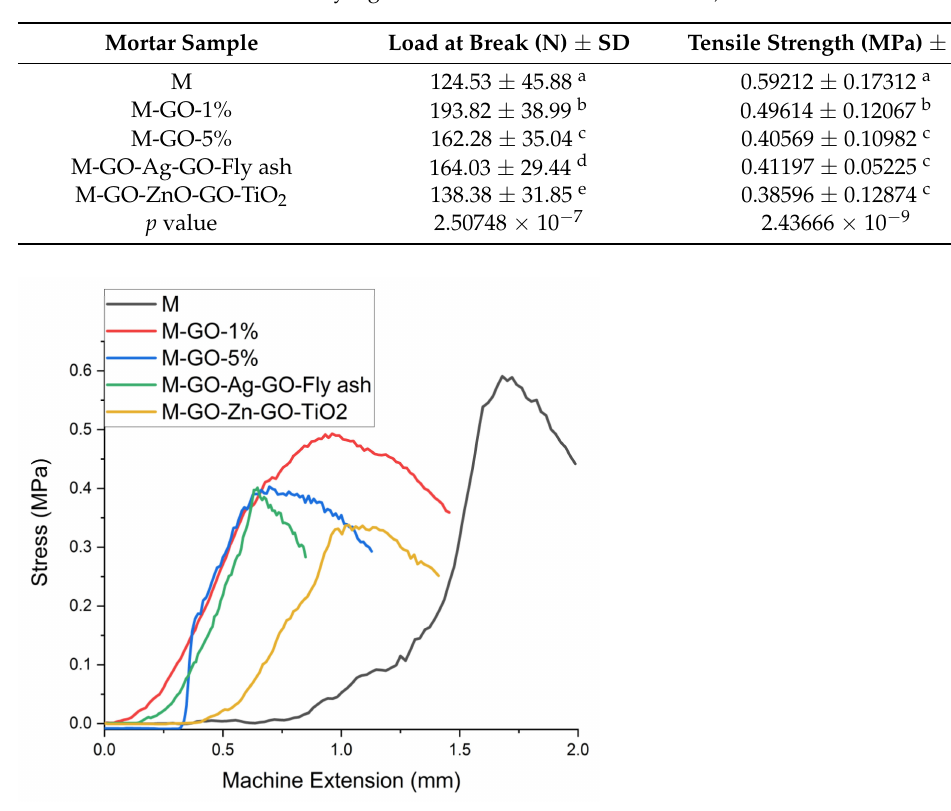
Figure 2. Stress–strain curves in the compression test of the mortars.